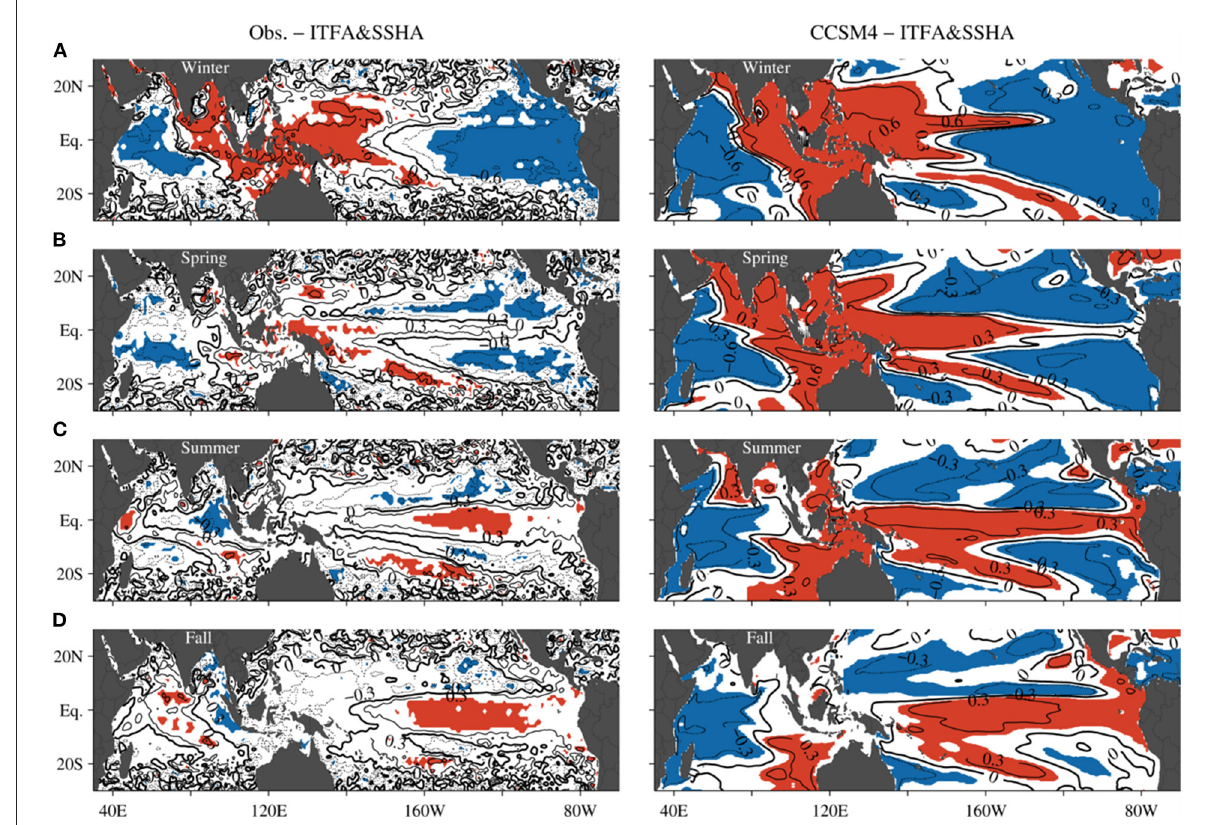
FIGURE8 Comparison of observed and simulated lag correlations of ITF transport anomalies in fall with the SSHA over the Indo-Pacific Ocean in the following four seasons during the positive phases of the decadal variability. The observed (simulated) ITF transport is the geostrophic transport above the main ocean thermocline across the IX1 section between western Australia and Java in reference to the 700m level-of-no-motion based on the XBT data (CCSM4 simulations). (A) Winter (December to February), (B) spring (March to May), (C) summer (June to August), (D) autumn (September to November). The contour interval is 0.3. Red and blue shades indicate 95% confidence level of positive and negative correlation,